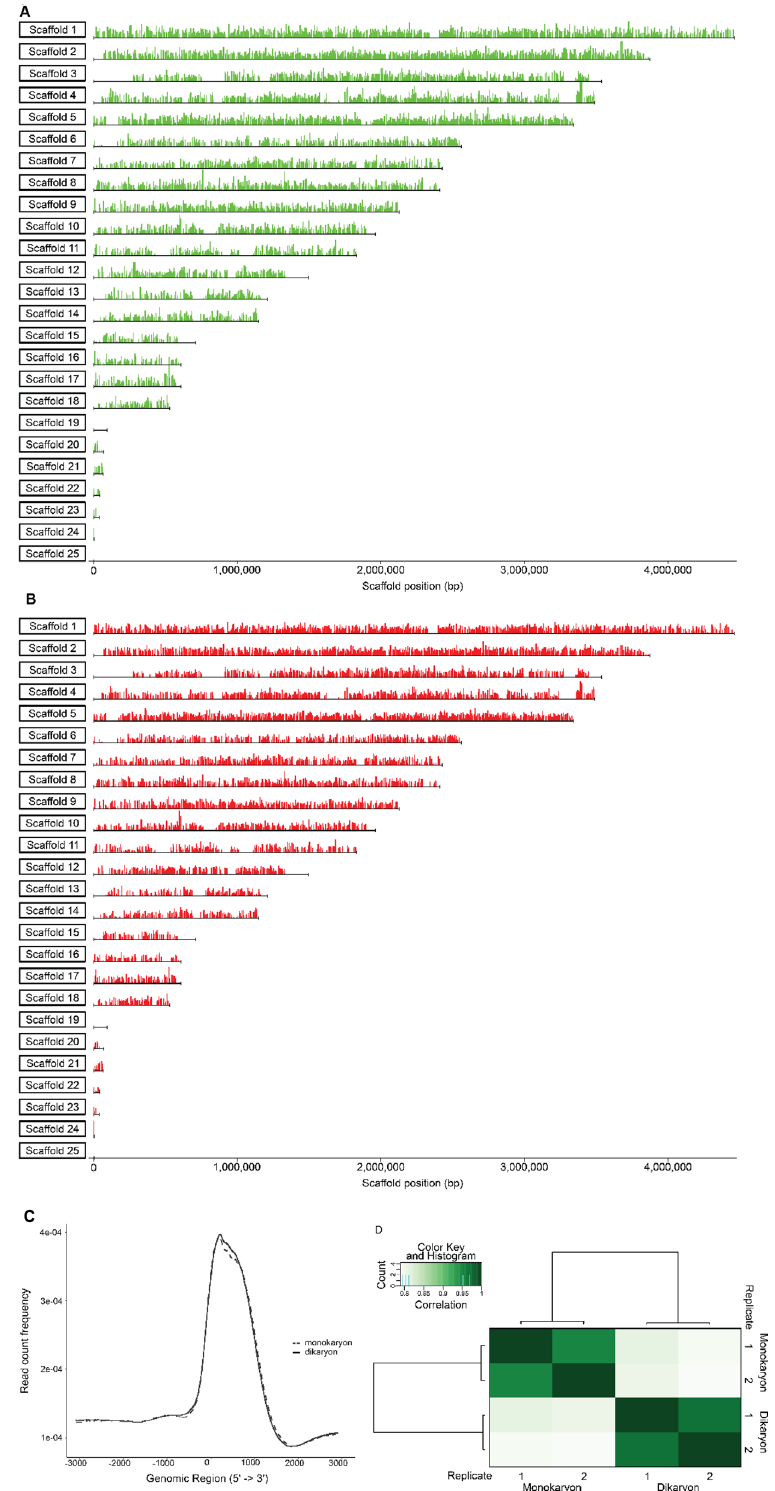
Figure 4. H3K4me2 peak distribution during monokaryotic and dikaryotic development. ( A ) Distribution of H3K4me2 across the S. commune genome during monokaryotic development. ( B ) Distribution of H3K4me2 across the S. commune genome during dikaryotic development. ( C ) Read count frequency 6000 bp around the translation initiation site (TIS) of genes with a peak in the monokaryon (dotted line) and dikaryon (continuous line) samples. The enrichment ranges from approximately 375 bp upstream to 1500 bp downstream of the TIS, with a summit 100 bp downstream of the TIS. The distribution of both monokaryotic and dikaryotic samples was very similar. ( D ) Correlation between samples and replicates obtained from H3K4me2 ChIP-Seq. The correlation between replicates of the same sample was > 0.95, while the correlation between the monokaryon and dikaryon samples was around 0.8. This indicates considerable conservation of the H3K4me2 landscape across the developmental